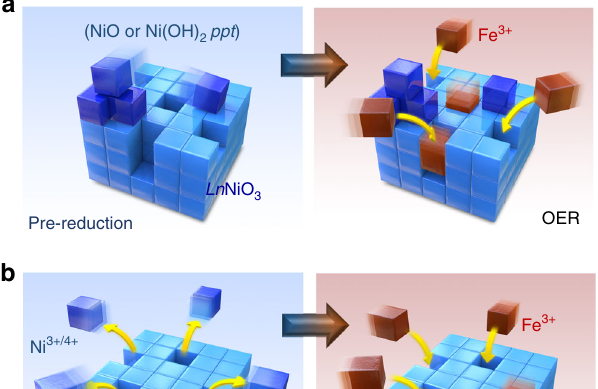
Comparison of OER activities and electrochemical impedances . The plots in Fig. 3a compare the OER current densities of the different types of thin- fi lm LaNiO 3 samples, which are pristine (gray), 5%-Fe-doped (black), and Fe-surface-exchange (blue and red). Five percent Fe was selected for the Fe-doped thin- fi lm because this level of doping was observed to show the highest OER activity among the Fe-doped LaNiO 3 fi lms (see Supple-